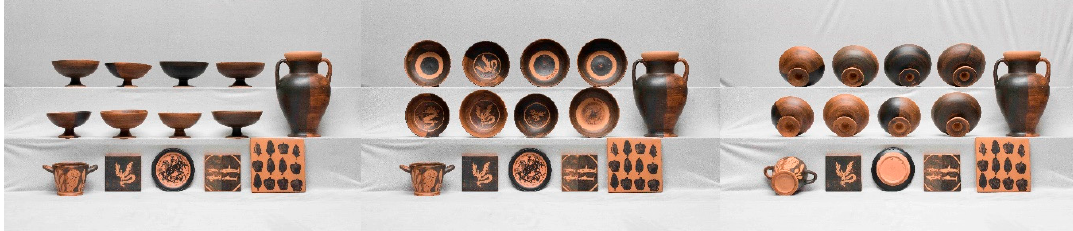
Figure 5. The fired wares produced in the November 2016 test firing. The black-figure plate was provided by Eleni Aloupi-Siotis of Thetis Authentics, Ltd., for test firing in our kiln.